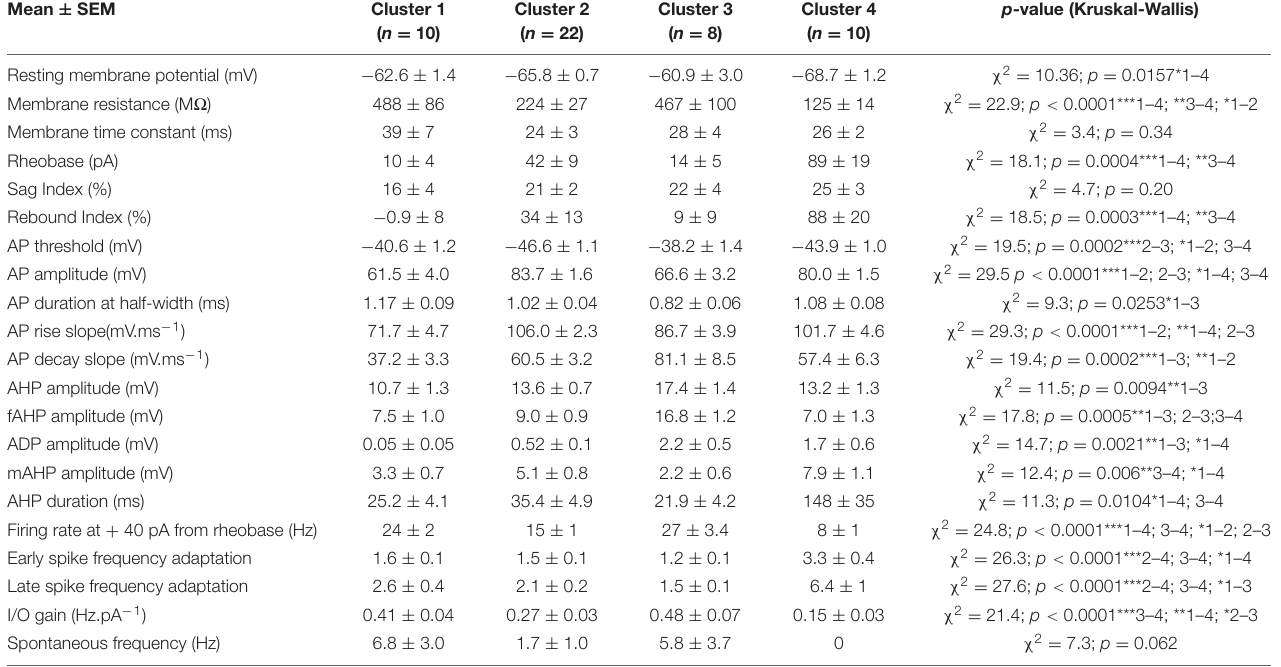
TABLE 5 | Electrophysiological properties of four